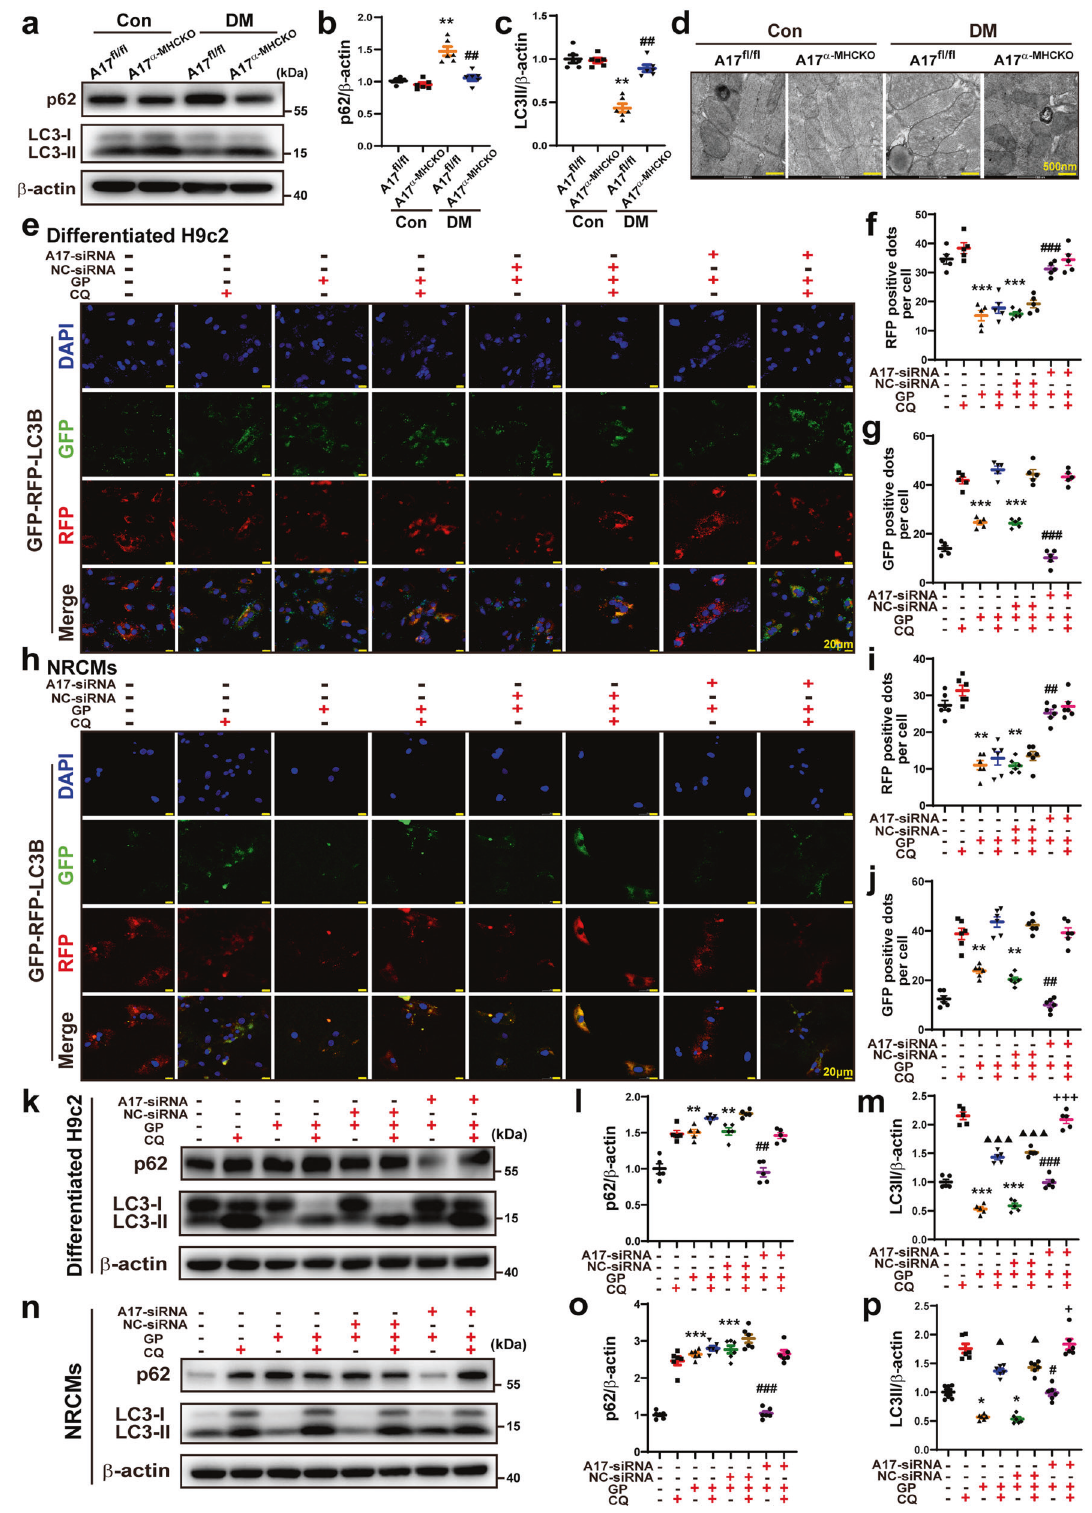
TGF- α , ICAM, VCAM, and ACE2 in a mouse model of DCM and found that only ACE2 mRNA level showed a signi fi cant change in the DCM mice than the control mice, suggesting that ACE2 plays a central role in the pathogenesis of DCM. Our results lent support to the notion that ACE2 is the main substrate of ADAM17 in the setting of DCM. between ACE2 mRNA and protein expression levels is supportive